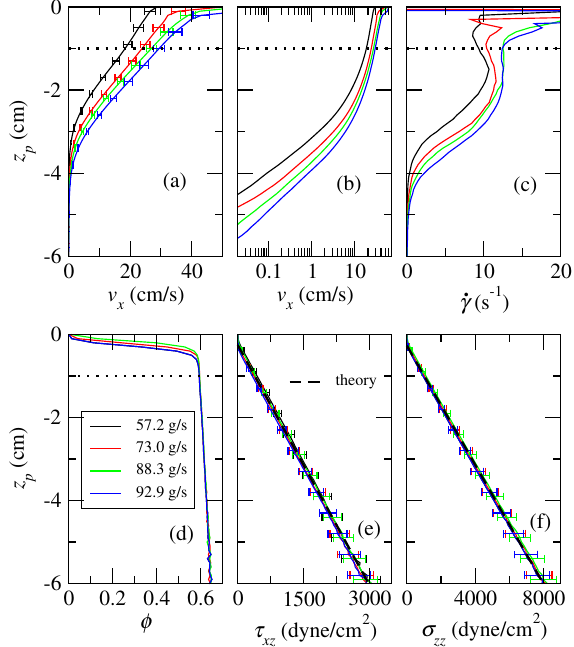
Figure 4. (a) Mean velocity ( v x ), (b) logarithm of mean velocity, (c) shear rate (˙ γ ), (d) volume fraction ( φ ), (e) shear stress ( τ xz ) and, (f) normal stress ( σ zz ) as a function of depth ( z p ) across the flowing region. Error bars based on the standard error are also shown for the velocity and stresses.The dotted line in (a), (b), (c), and (d) corresponds to I = 0 . 09.